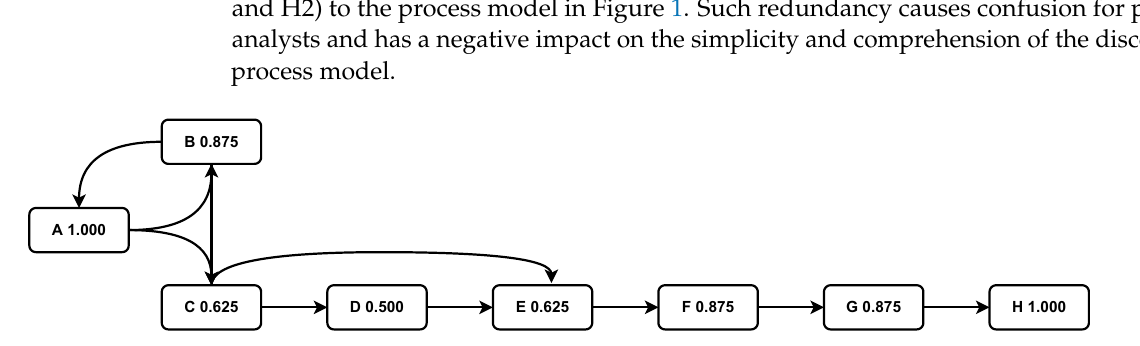
Figure 1. Process model discovered from clean event log L 1 .